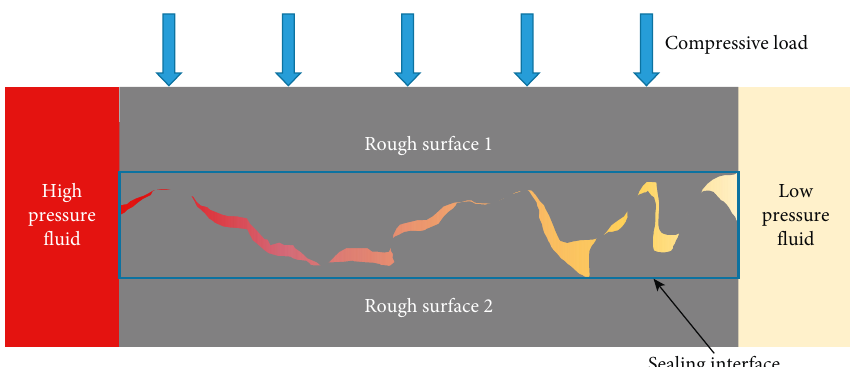
Figure 1: A schematic showing the flow of sealing medium through the sealing interface of metal-to-metal